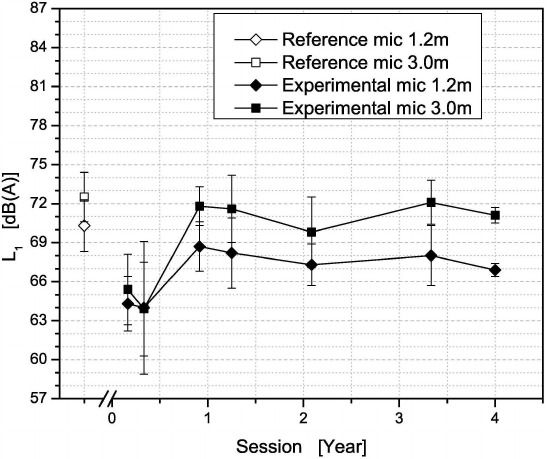
Figure 21. Time evolution of SPB values in Site 6. In white ante-operam